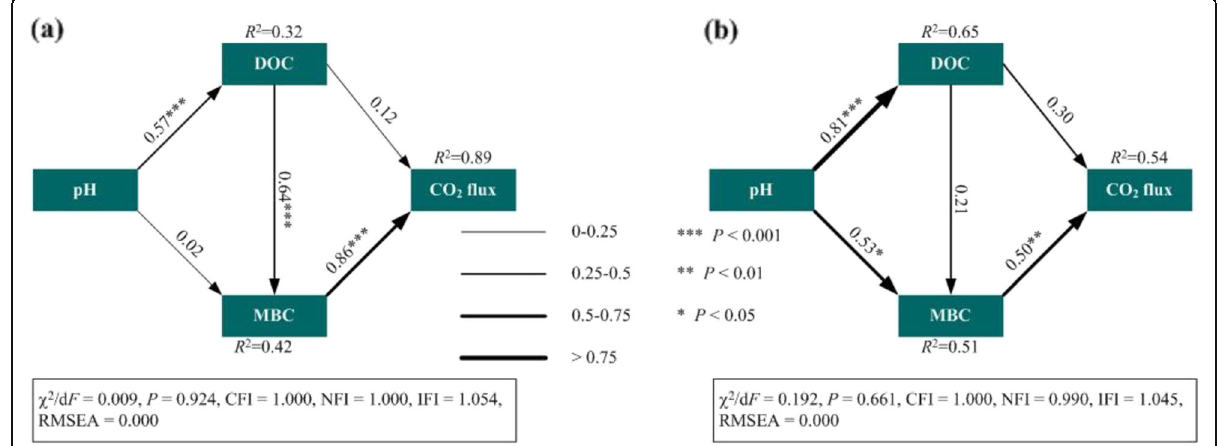
Fig. 6 Results of the path analysis showing the correlations among CO 2 fluxes and pH, DOC and MBC in soil S1 ( a ) and S2 ( b